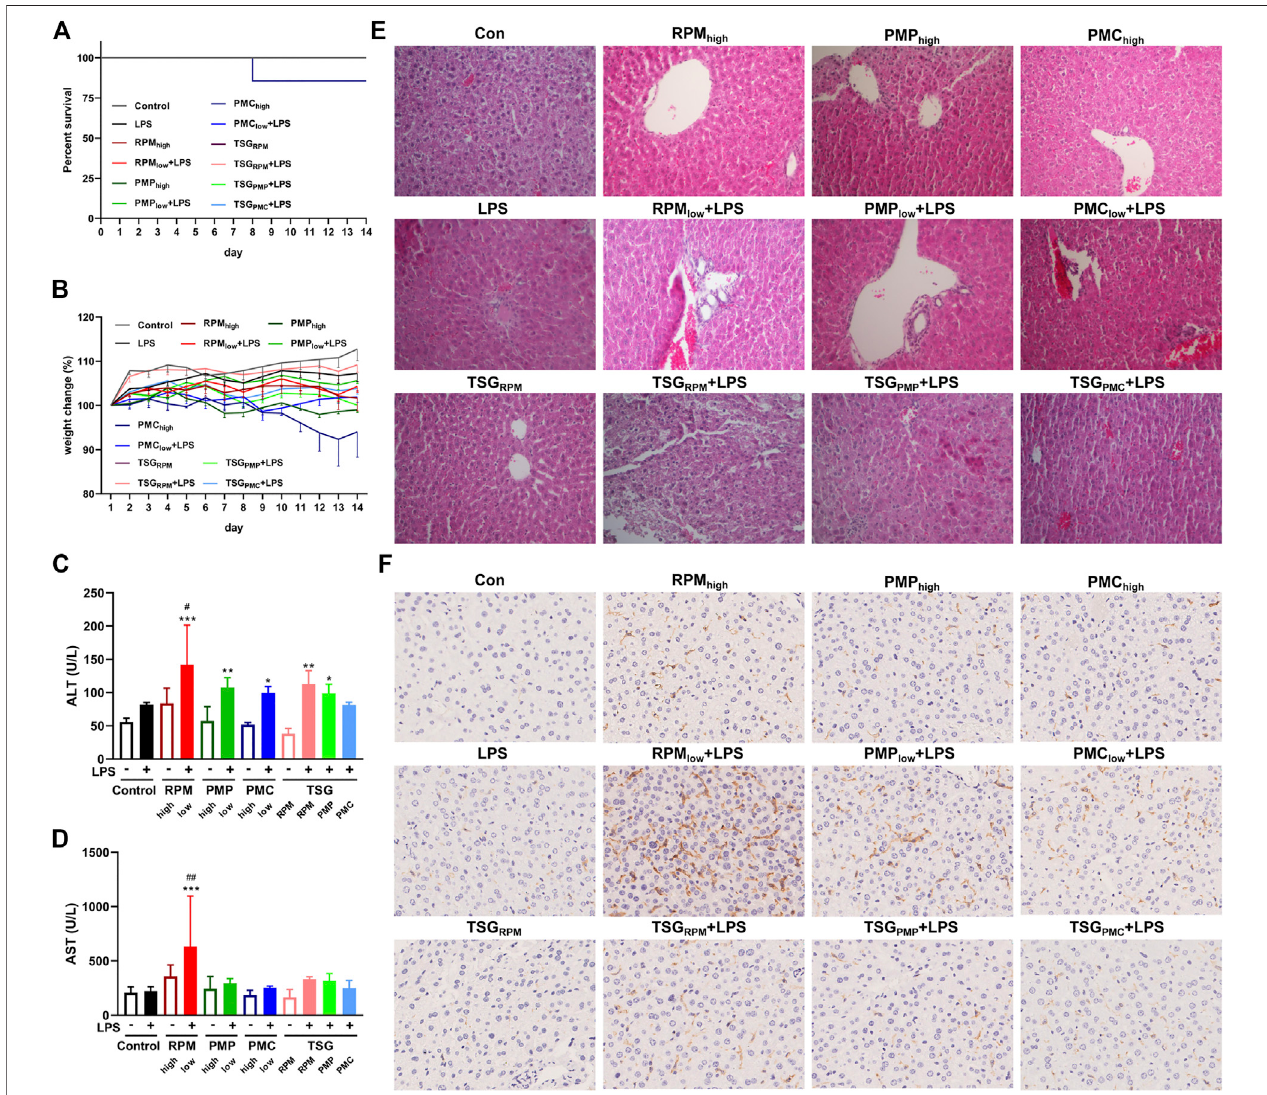
FIGURE4| DevelopmentofPM-and TSG-induced liverinjuryinLPS-injectedmice.RPM high ,PMP high ,PMC high :30 g/kg/d,14 days,ig.RPM low ,PMP low ,PMC low : 6 g/kg/d, 14 days, ig. TSG RPM : 0.462 mg/kg/d cis -SG and 40 mg/kg/d trans -SG, 14 days, ig. TSG PMP : 0.45 mg/kg/d cis -SG and 18 mg/kg/d trans -SG, 14 days, ig. TSG PMC : 0.18 mg/kg/d cis -SG and 4.8 mg/kg/d trans -SG, 14 days, ig. LPS: 0.5 mg/kg, 2 h before igon day 14, iv. All micewere killed for sample collection6 h after ig on day 14. (A) Survival percent of each group during the treatment ( n = 7). (B) Body weight changes of each group during the treatment (n = 6, mean ± SEM). The serum levels of ALT (C) and AST (D) of each group ( n = 6). Mean ± SD, * p < 0.05, ** p < 0.01, *** p < 0.001 vs. control group, # p < 0.05, ## p < 0.01 vs. LPS group by ANOVA. (E) Representative images of HE staining from liver sections of each group (200×). (F) Representative IHC images of F4/80 staining from liver sections of each group